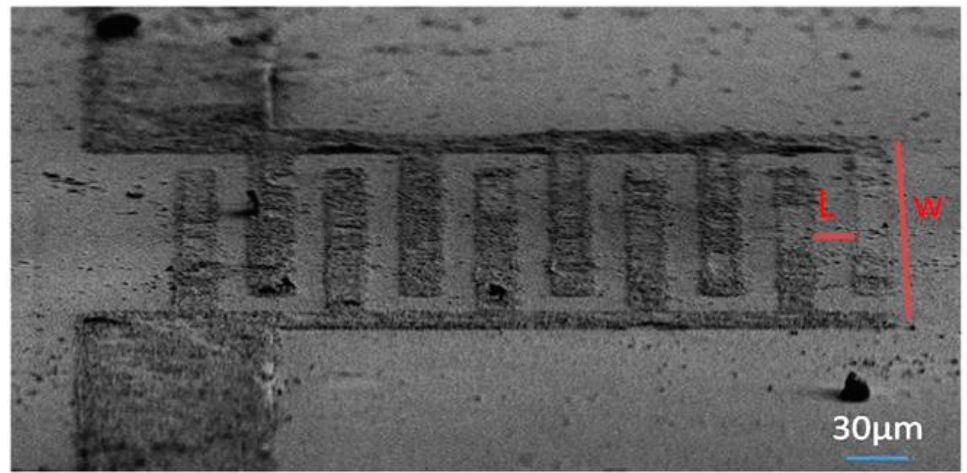
Figure 5. SEM images in a tilted-view of ID contacts after the synthesis for 5 minutes of ZnO nanowalls.